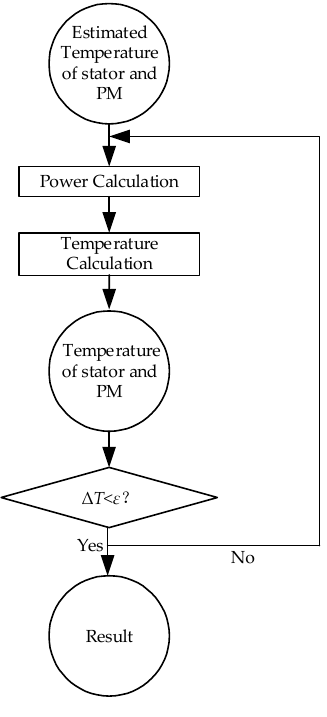
Figure 15. Flowchart of the thermal power-temperature coupled calculation.